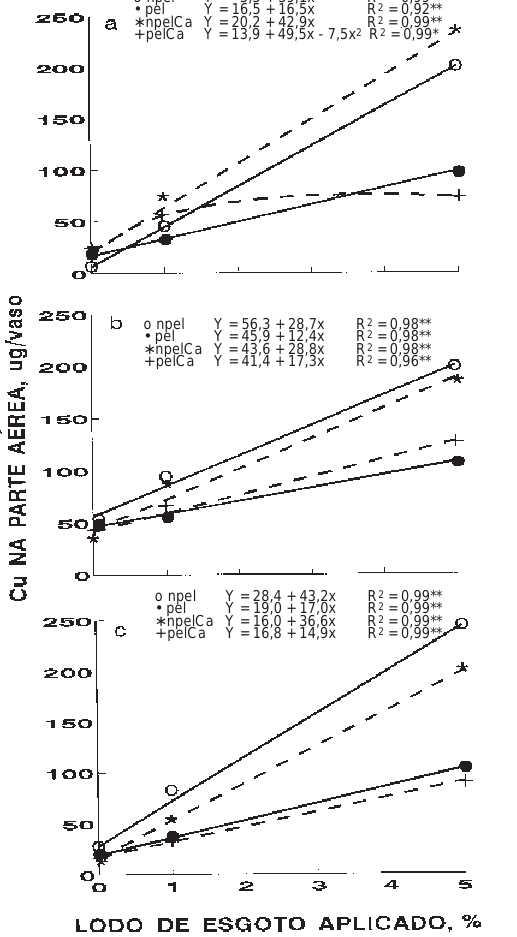
Figura 4. Quantidades absorvidas de Ni pela